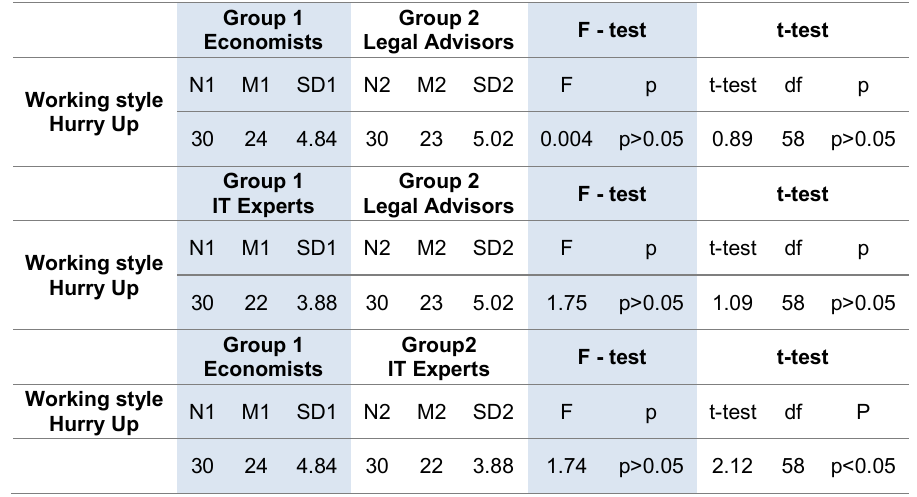
Table 3: Analysis of the differences between the three professions regarding the working style Hurry Up